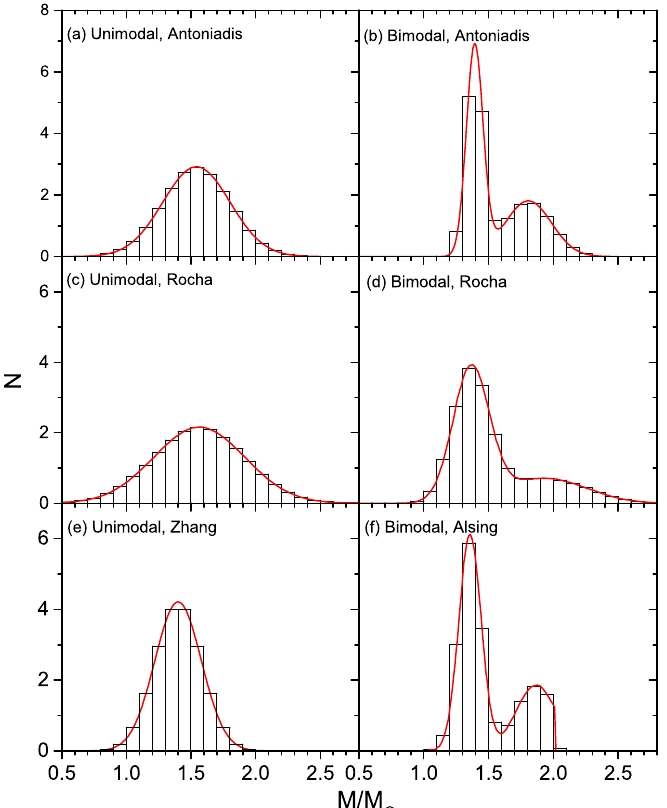
Figure 6. Theoretical NS mass distributions by several authors [82–85] (red curves) binned and normalized in the same way as Figure 5 (black